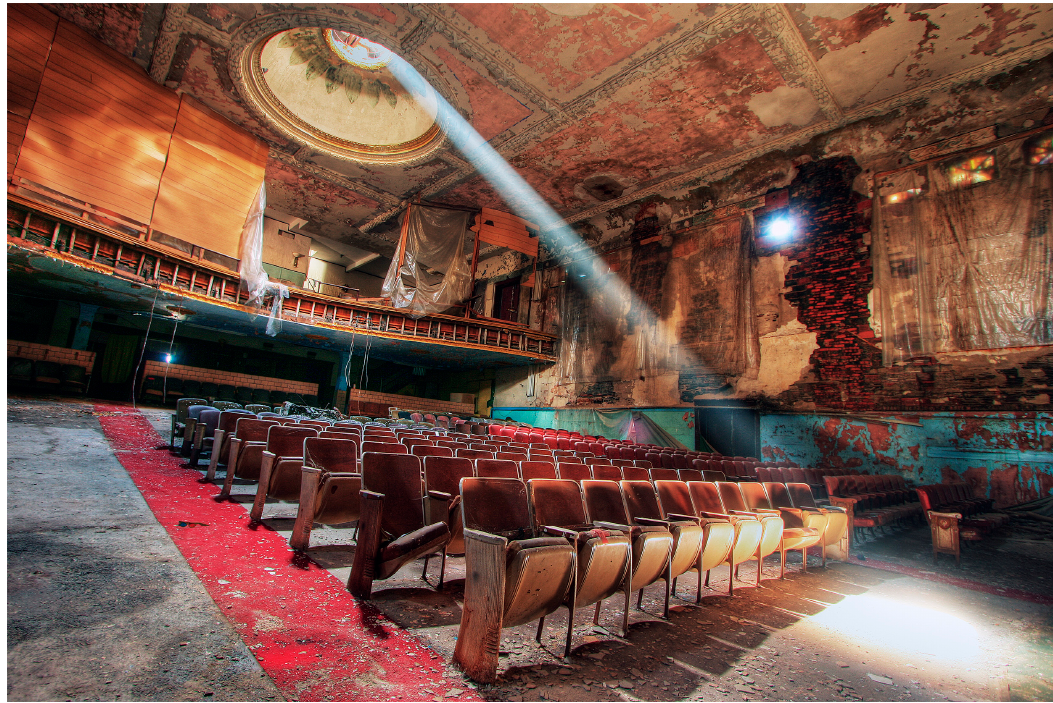
Figure 1 . “Broadway” by Timothy Neesam. Figure 1. “Broadway” by Timothy